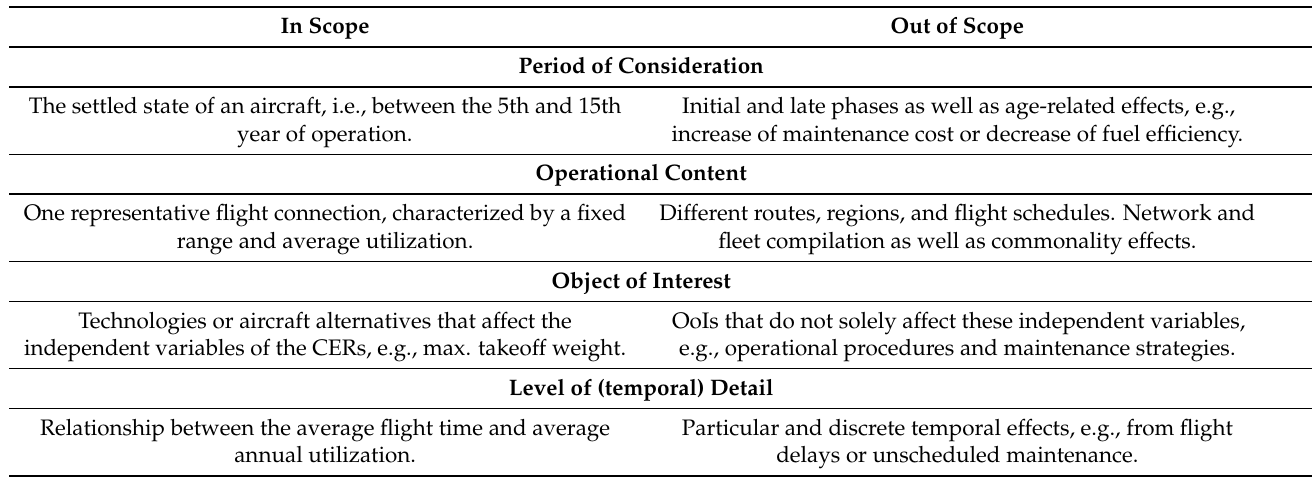
Table 1. Scope and limitations of DOC methods, based on Schnieder [15] with own